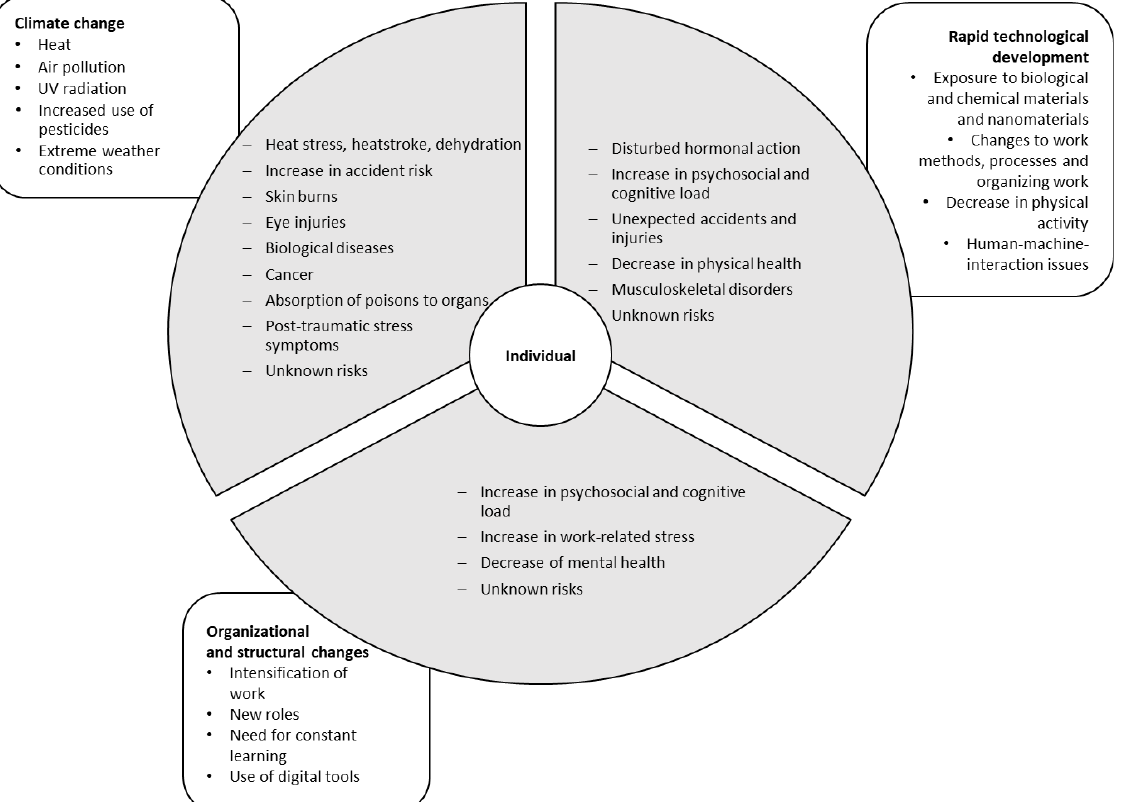
Figure 3. Summary of the OSH challenges (white boxes) and their potential effects at an individual level